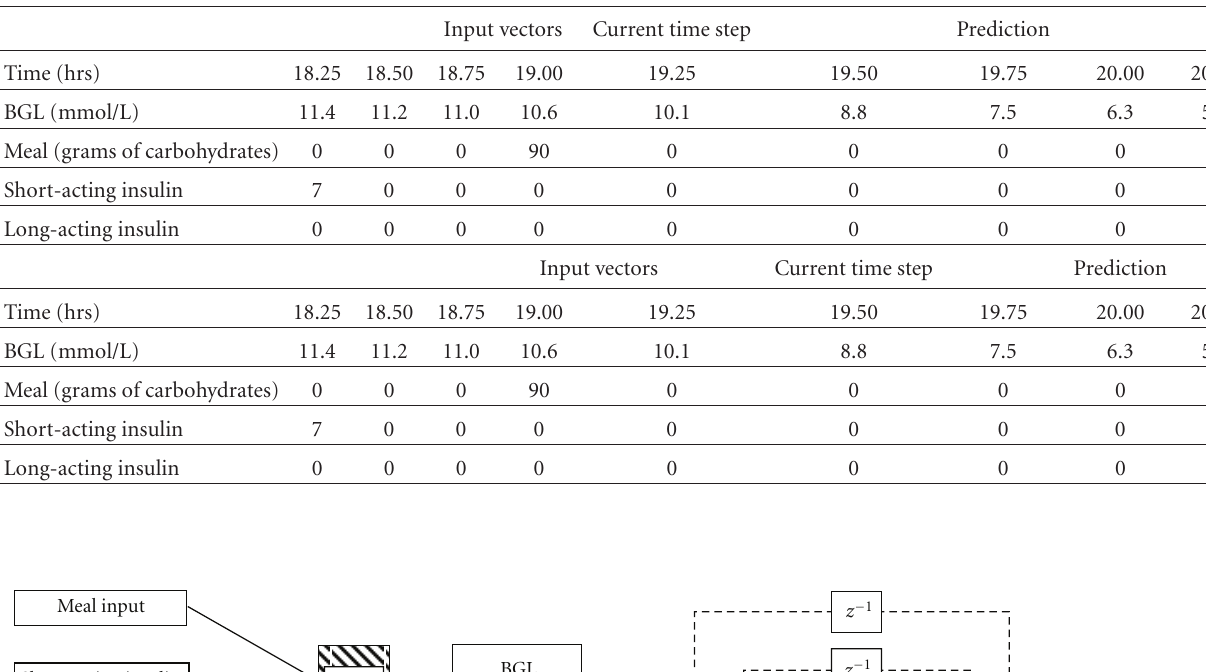
Table 1: Incremental progression of the input vectors, current time-step, and BGL prediction used for ANN training.